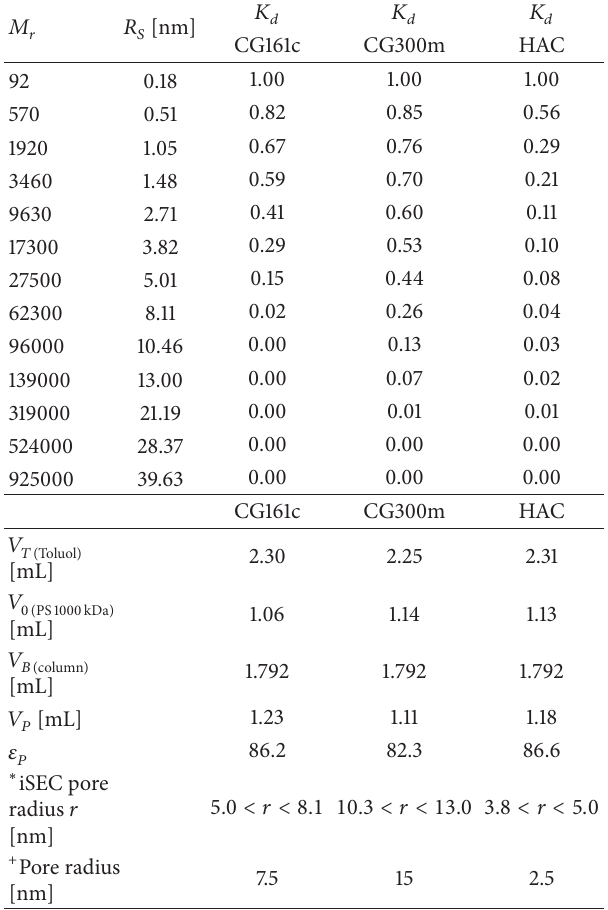
Table 2: Summary of inverse size exclusion chromatography. The pore size of the adsorbents was determined by SEC using polystyrene standards. 𝑅 𝑆 : stokes radius; 𝐾 𝑑 : SEC distribution coef-